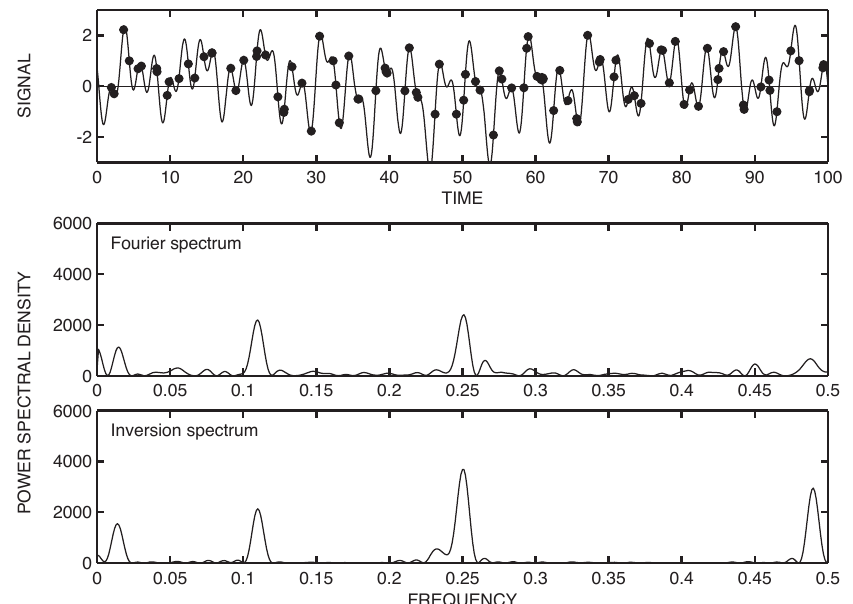
Fig. 6. Same as Fig. 2, but sampling times are randomised. The Fourier spectrum is calculated from all samples as if the sampling interval would be equal, but the true sampling times are used in calculating the inversion spectrum.